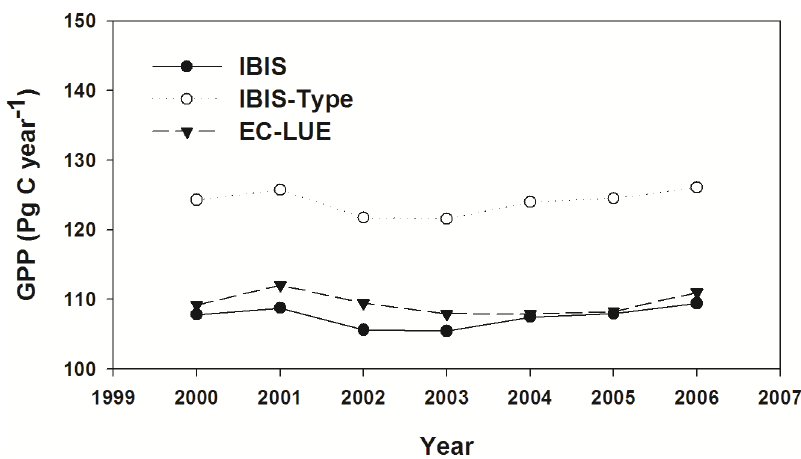
Figure 5. Interannual variability in GPP derived from different models. Interannual variability in global mean gross primary production (GPP) derived from the IBIS, IBIS-Type and EC-LUE models.